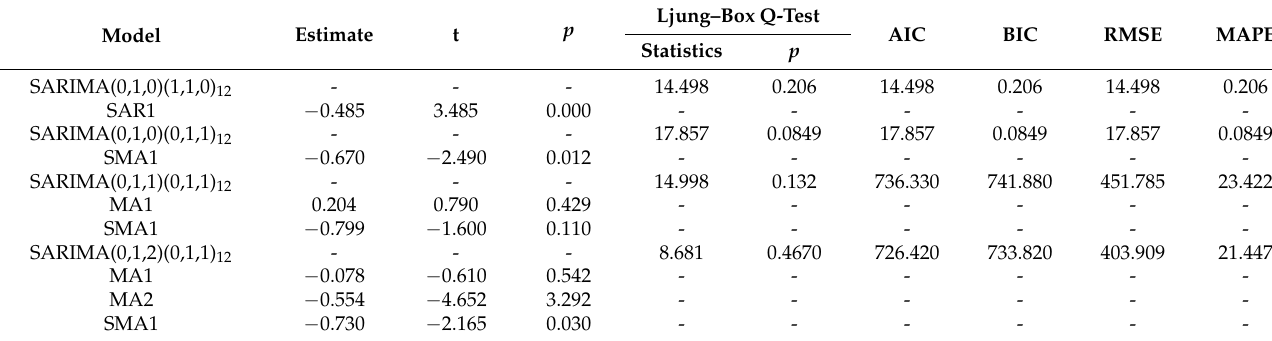
Table 3. SARIMA model